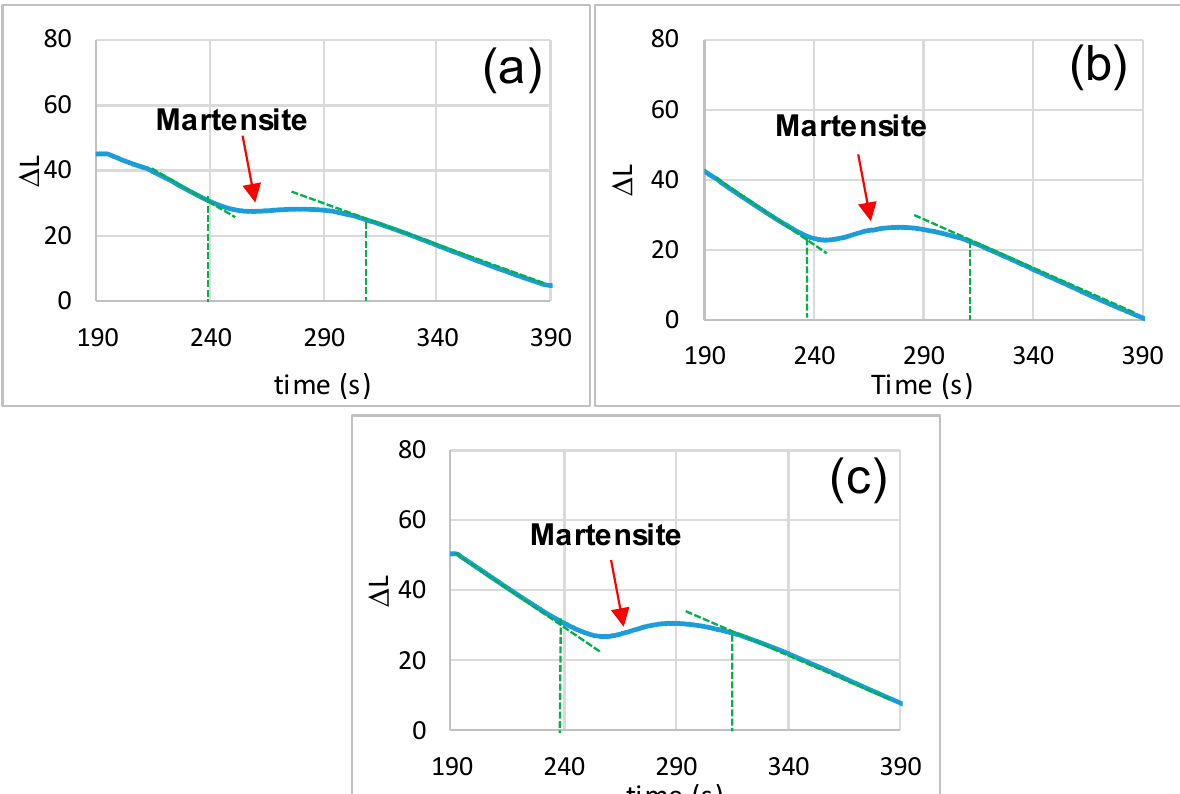
Figure 10. Δ L vs. time curves showing the variation in slopes during final cooling of samples with isothermal bainitic treatment conducted at: ( a ) 425 °C, ( b ) 450 °C, and ( c ) 475 °C.